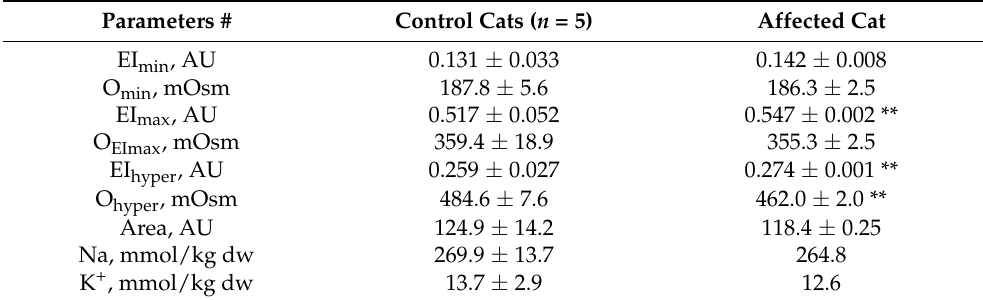
Table 2. Erythrocytic hydration and osmotic fragility parameters of a cat with hereditary CYB5R3 deficiency during steady-state conditions.